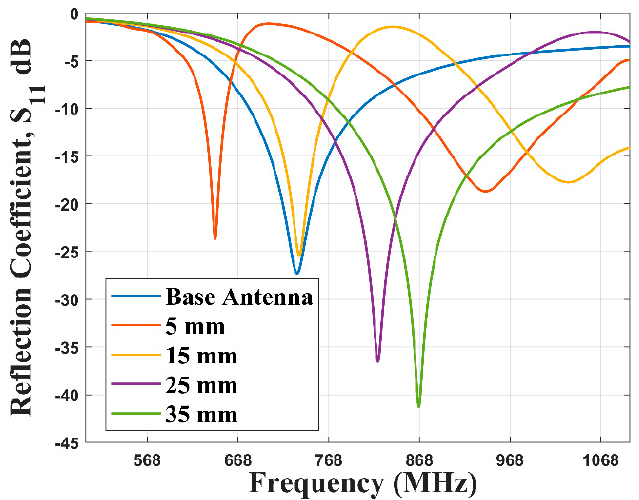
Figure 12. Reflection coefficient of braided antennas (with varied length).